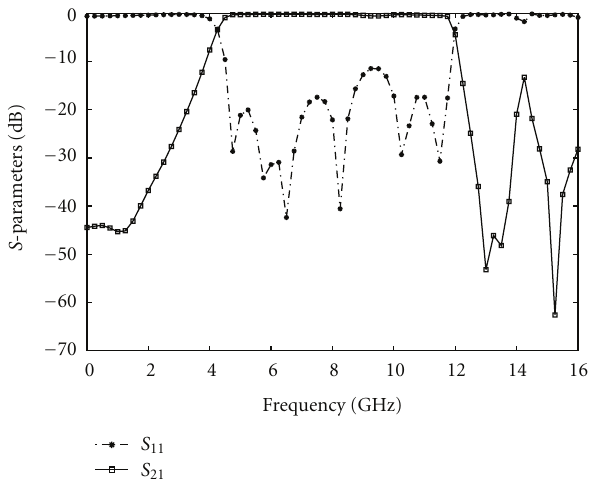
Figure 15: Scattering parameters for the bandpass resonator constructed by cascading three cells of DS-UC by